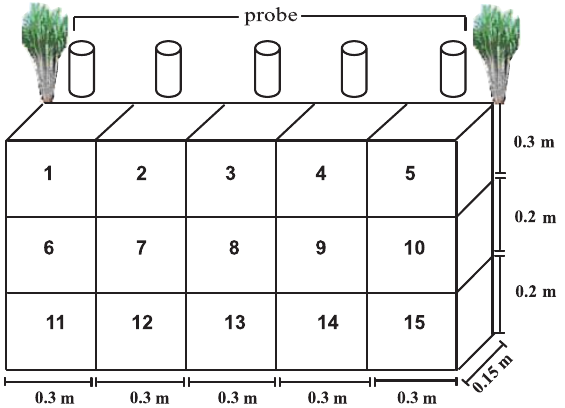
Figure 1. Sampling scheme of the root system by means of probes and monoliths taken from trench-profile